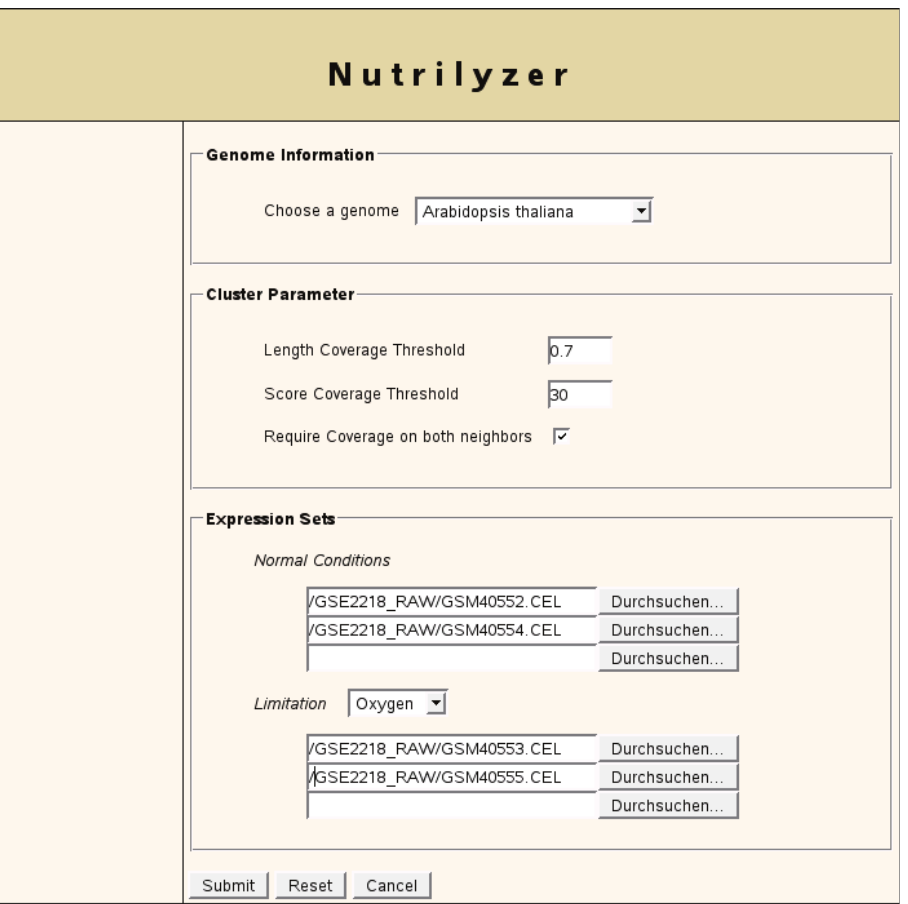
Figure 1: Screenshots of Nutrilyzer: Start page. Graphical user interface to select organism and cluster parameters, to input gene-expression data and choose limited